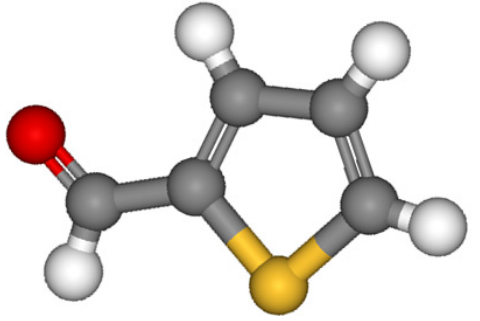
Figure 1. The structure of the TPCA molecule, which has a sulfur (yellow), an oxygen (red), five carbons (gray), and four hydrogens (white),